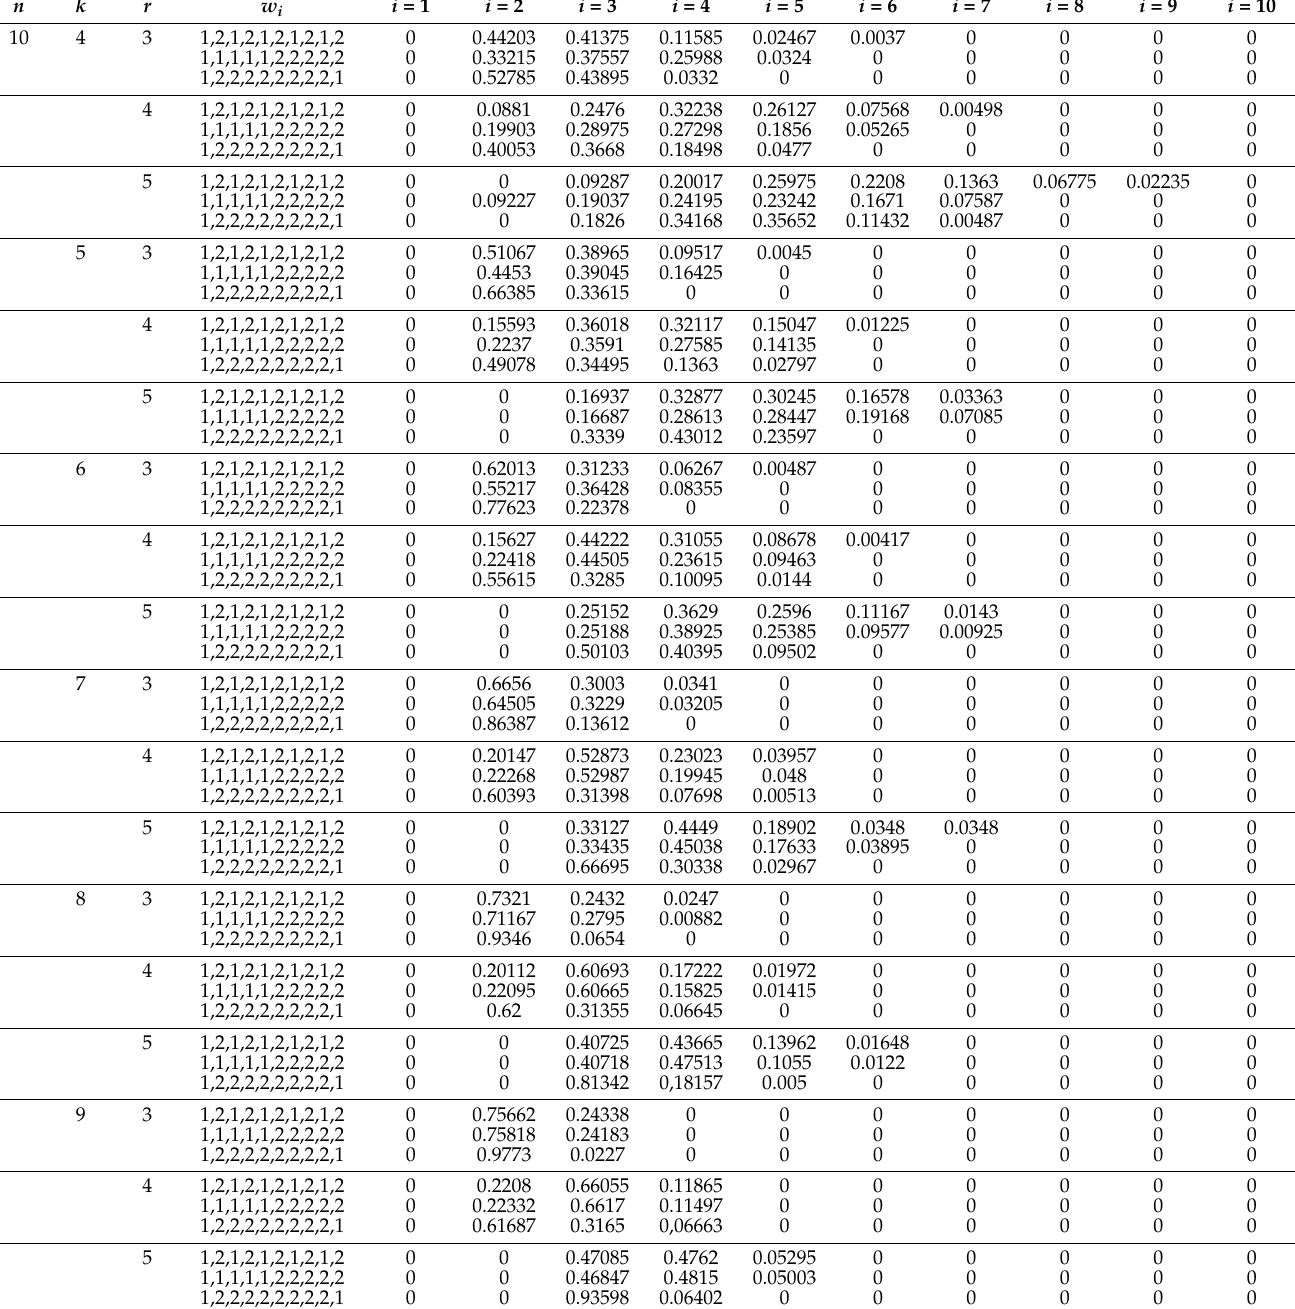
Table 6. The signature of the weighted- r -within-consecutive- k -out-of-10: F